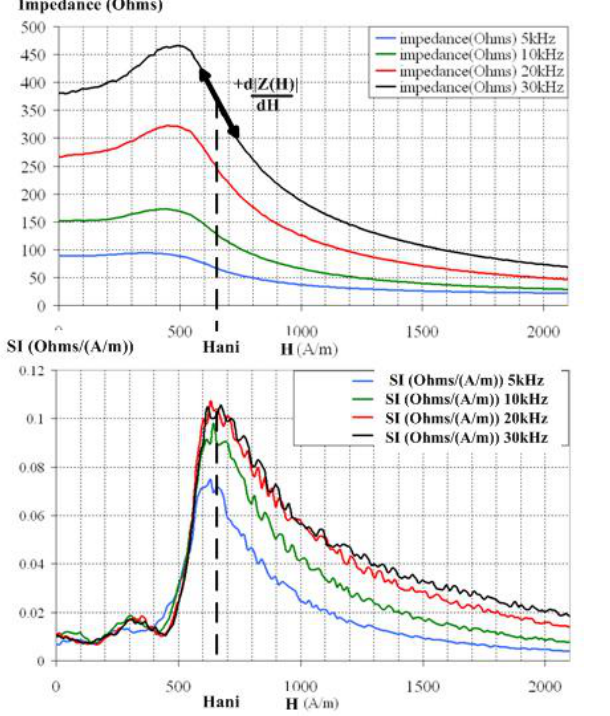
Figure 3. Variations with the magnetic field H of the modulus of the impedance (upper frame) and intrinsic sensitivity (lower frame) of a longitudinal wire-wound magnetic ribbon.